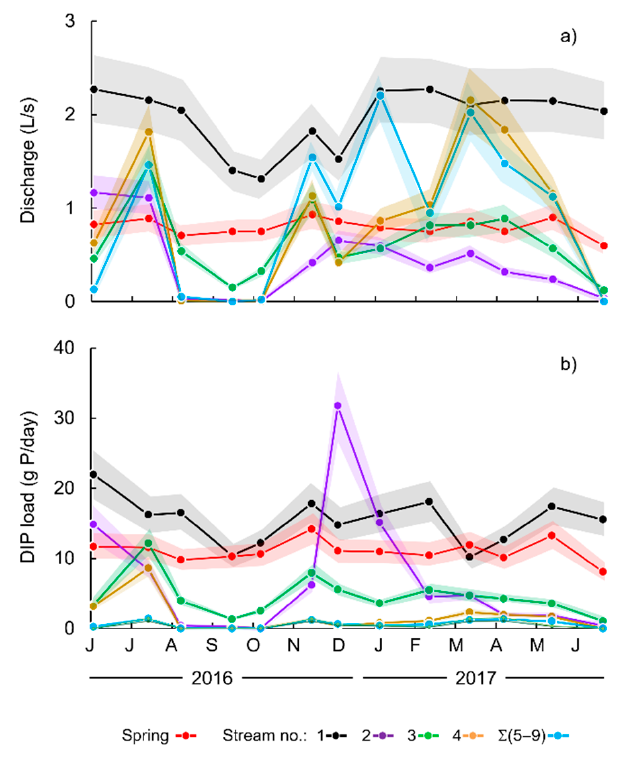
Figure 6. ( a ) Discharge rates and ( b ) DIP load to Lake Nørresø from the spring (red) and streams 1 (black), 2 (purple), 3 (green), and 4 (brown), and the sum of streams 5 to 9 (blue). Shaded area behind the lines represents ±1 standard deviation of the cutthroat flume stream discharge measurement.